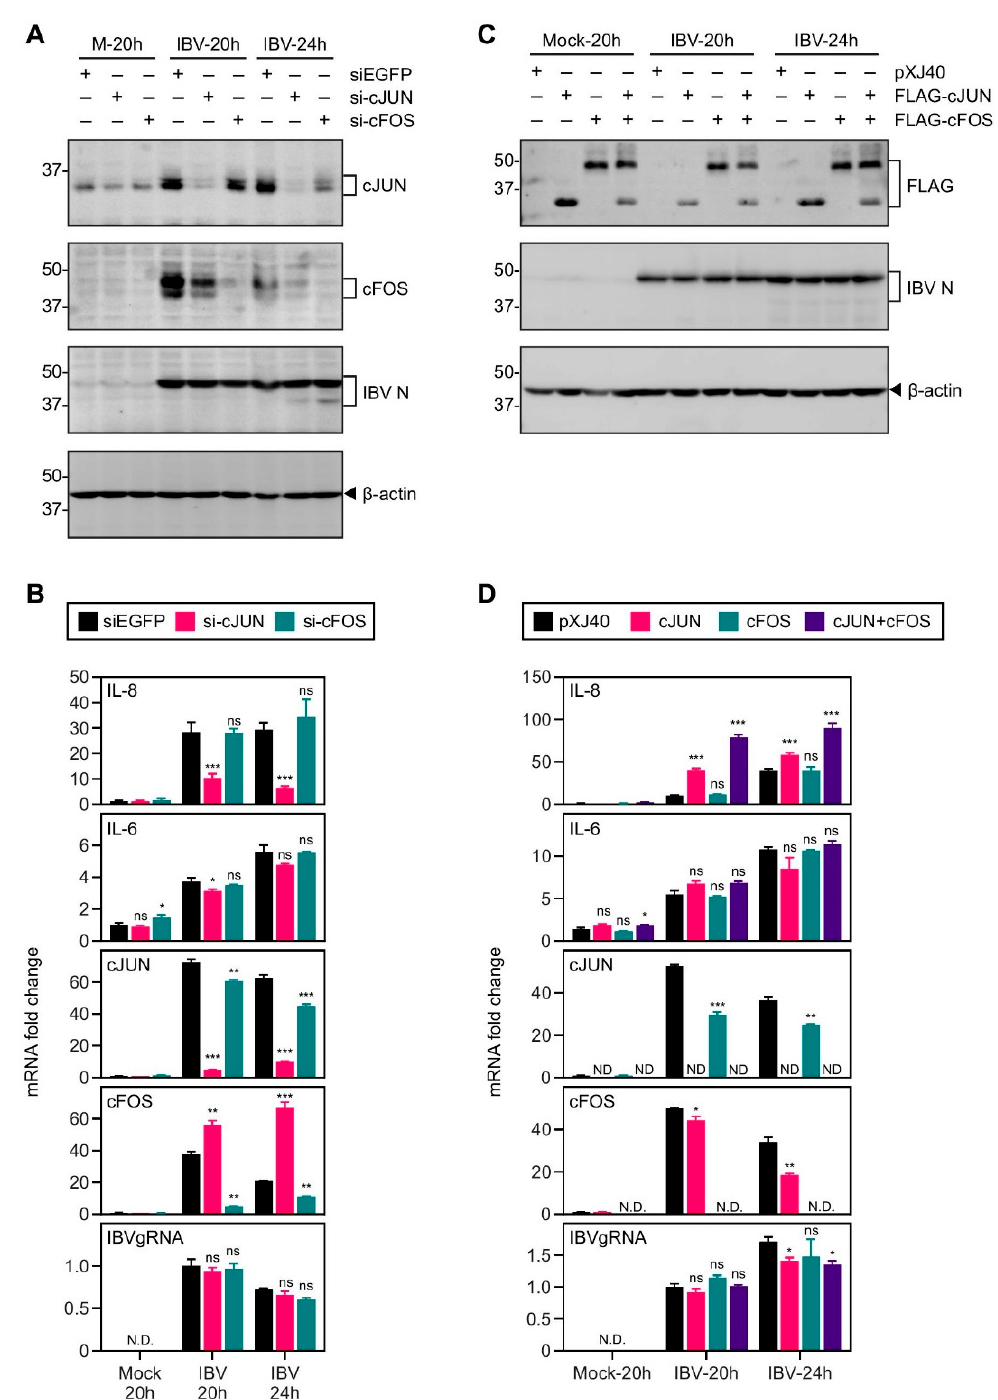
Figure 5. cJUN and cFOS synergistically induced IL-8 mRNA expression in cells infected with IBV. ( A ) H1299 cells were transfected with siEGFP, si-cJUN, or si-cFOS, before being infected with IBV at MOI~2 or mock infected (M). Cell were harvested at the indicated time points and subjected to Western blot analysis using the indicated antibodies. Beta-actin was included as the loading control. Sizes of protein ladders in kDa are indicated on the left. ( B ) Total RNA samples were extracted from cells in (A) and subjected to RT-qPCR. The levels of IL-8, IL-6,cJUN, cFOS, and IBV genomic RNA were determined by the ∆∆ Ct method using the GAPDH mRNA of the siEGFP-transfected, 20 h post mock-infected sample for normalization. The experiment was repeated three times with similar results, and the result of one representative experiment is shown. Significance levels were presented by the p -value (ns, non-significant; *, p < 0.05; **, p < 0.01; ***, p < 0.001; N.D., non-determined). ( C ) H1299 cells were transfected with pXJ40, pXJ40-FLAG-cJUN, pXJ40-FLAG-cFOS , or an equal molar